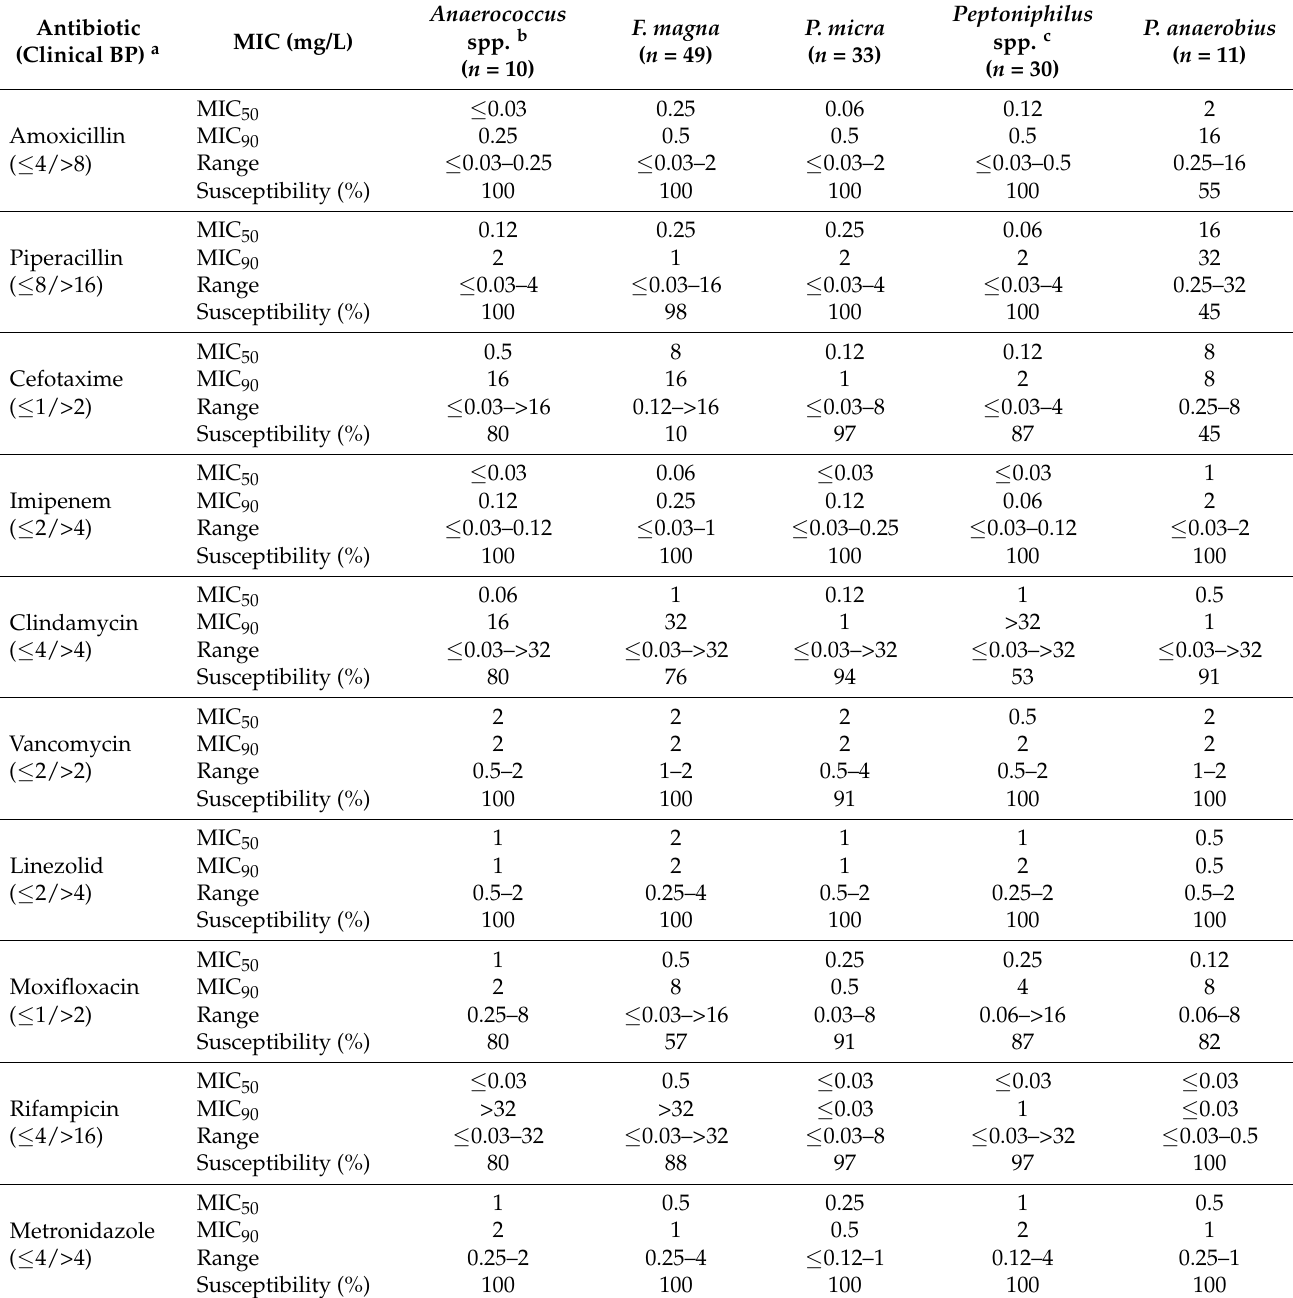
Table 1. Antimicrobial susceptibility profiles of the 133 GPAC human invasive